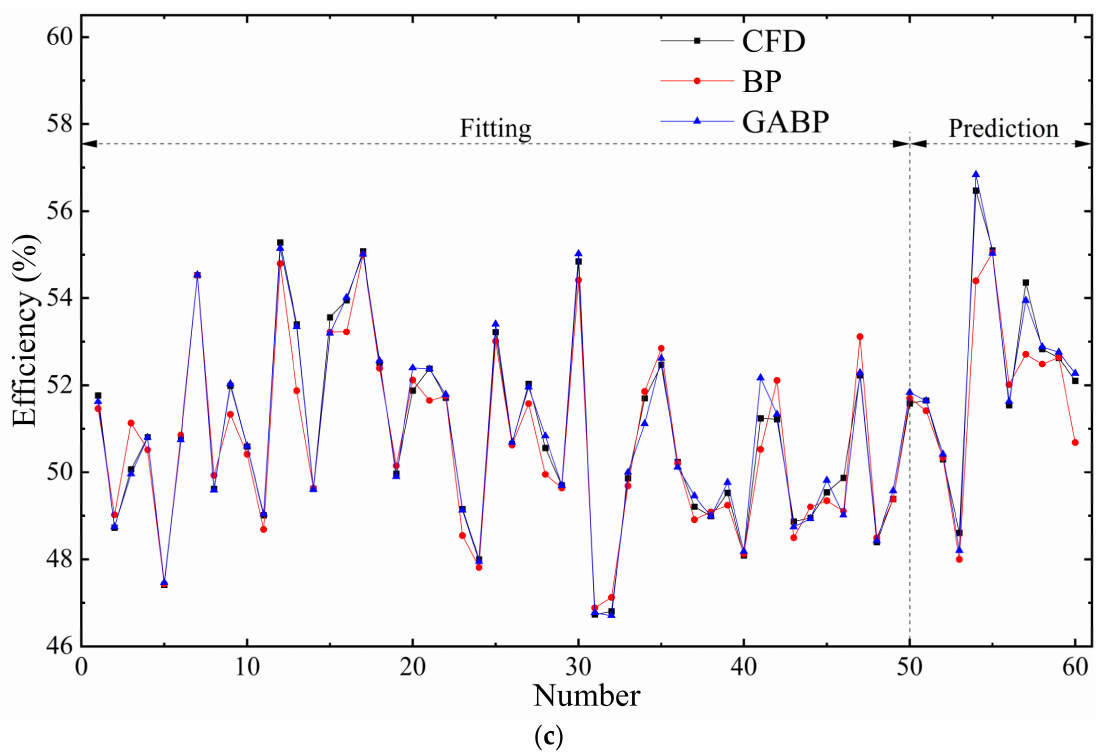
Figure 10. Comparison of the performance of the BP and GABP neural network: ( a ) Head; ( b ) Shaft Power; ( c ) Efficiency.